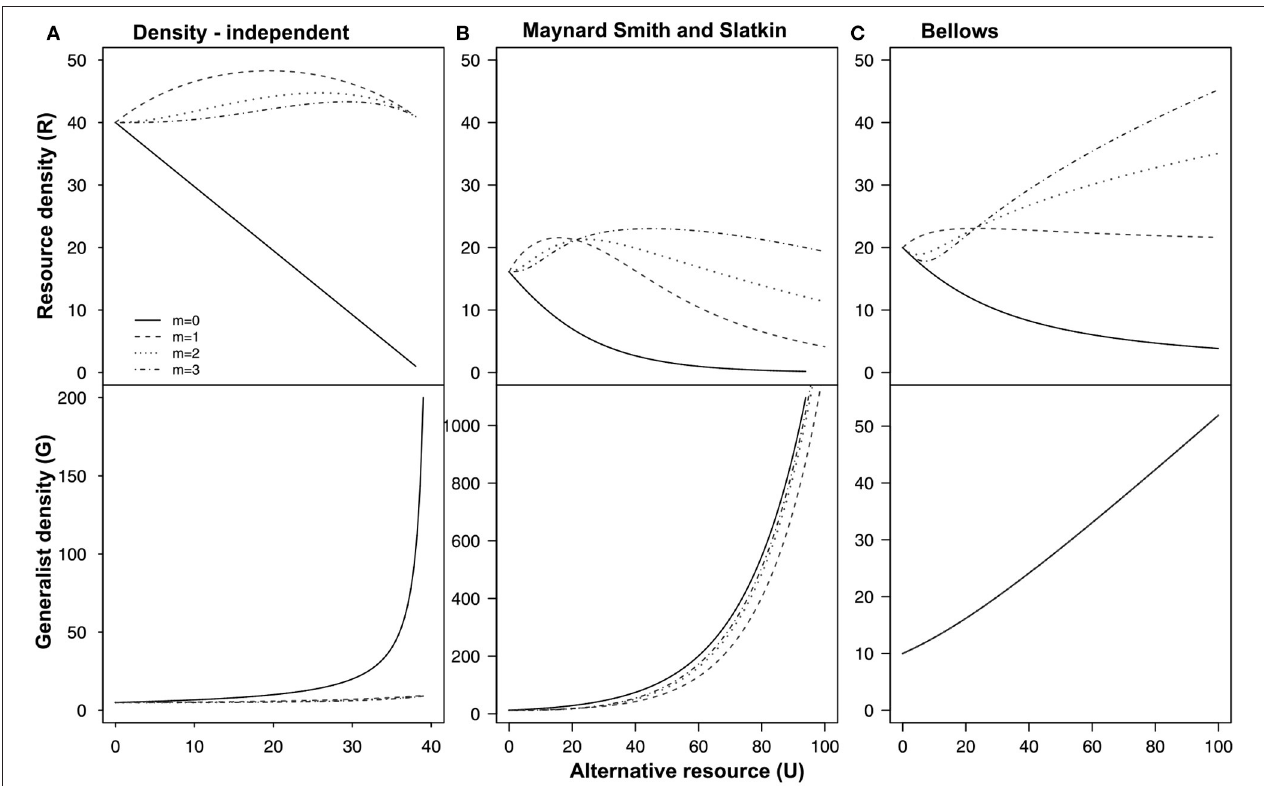
FIGURE 3 | Graphical representation of the population equilibria at different values of U and m under: (A) density-independent conditions; (B) Maynard Smith & Slatkin density-dependence; (C) Bellows density-dependence. Resource consumer preference is determined by R ( t ) m from 0 to 45. The different lines represent: Solid m and µ R 0.001 under density-independent conditions and under density-independent conditions α = the figure are obtained using bifurcation